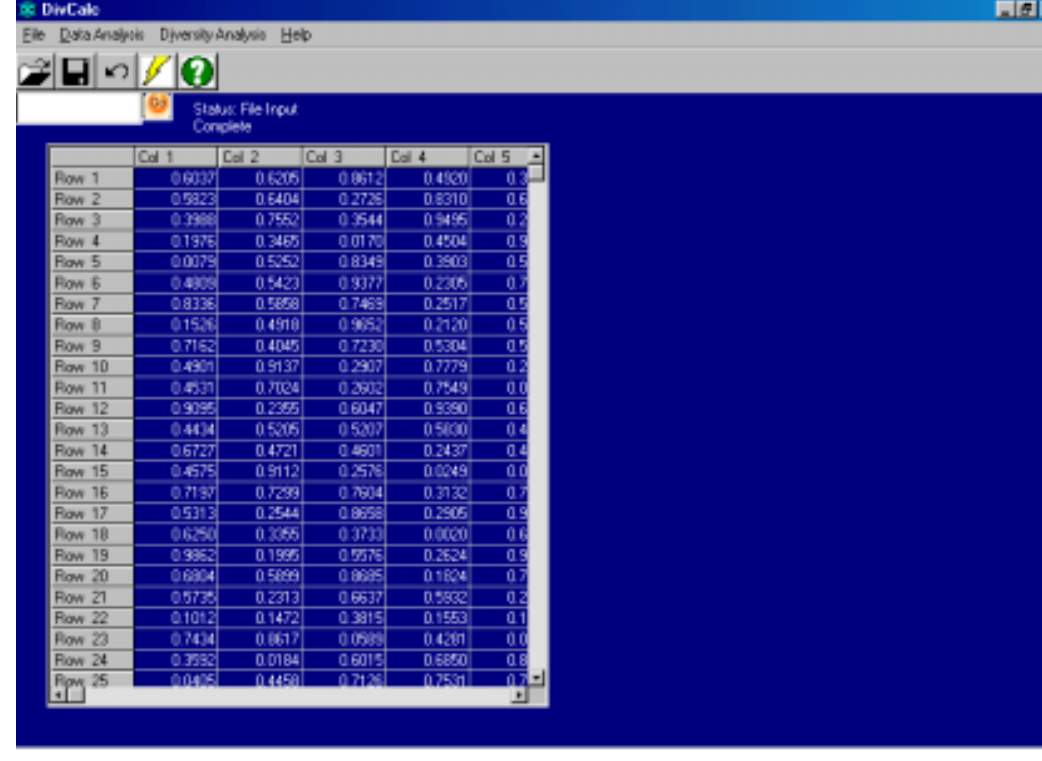
Figure 1. Main interface screenshot of DivCalc